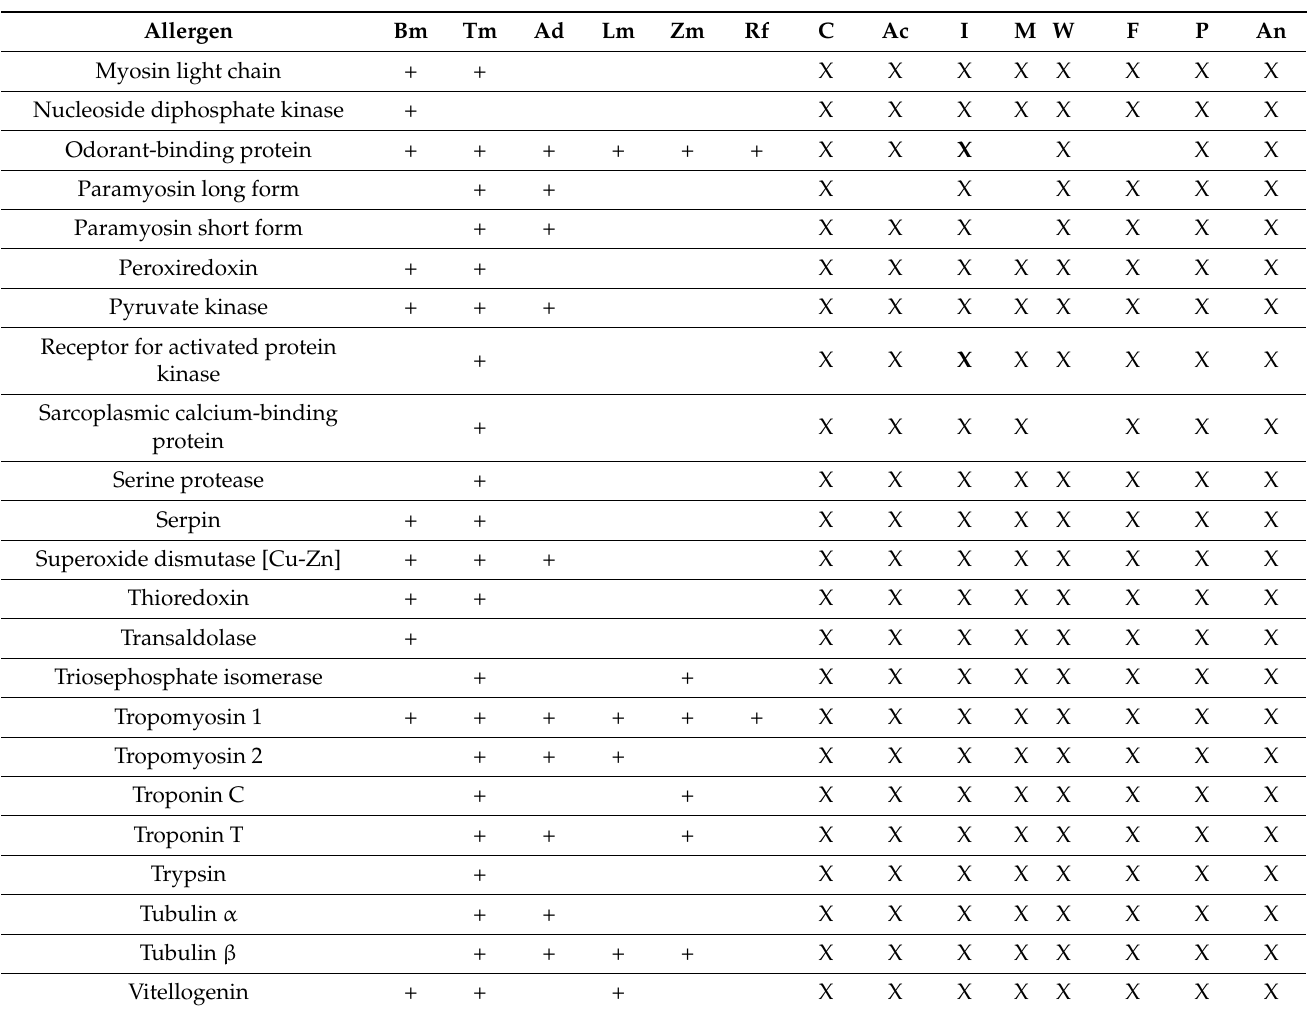
Table 3. Number and proportion (expressed as %) of specific proteins identified in insects, crustaceans, mollusks and nematods. N/I: protein not identified. Green: highly specific insect proteins. Protein: Insects: Crustaceans: Mollusks: Nematods: Apolipophorin III